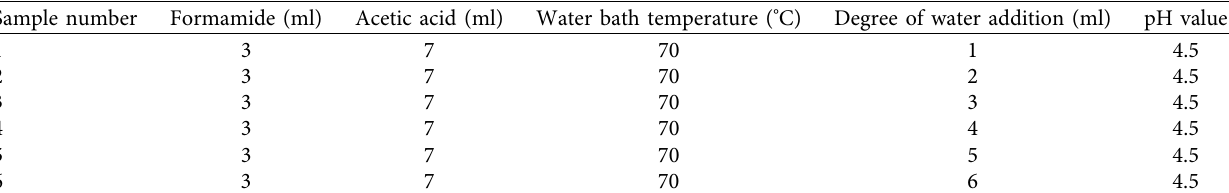
Table 3: Precursor solution preparation parameters with different amounts of water added.